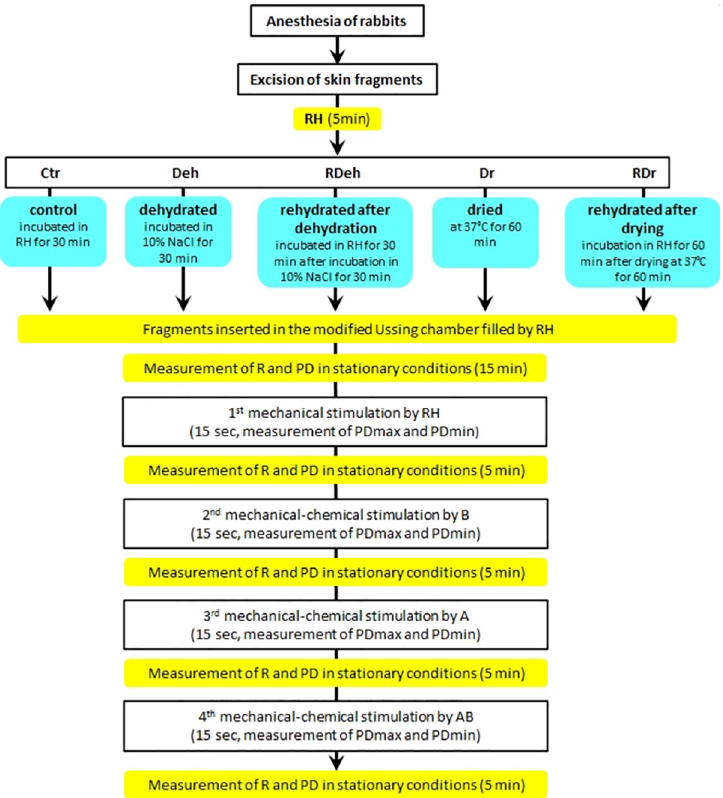
Fig 1. Study design. Abbreviations: RH–Ringer’s solution; NaCl–sodium chloride 10% (1.71 M) in RH; B–bumetanide solution (0.1 mM), used as a blocker of the Na + –K + –Cl – –cotransporter; A–amiloride solution (0.1 mM), used as blocker of ENaC (epithelial sodium channel); AB–solution of amiloride (0.1 mM) and bumetanide (0.1 mM); PD– transepithelial potential difference of the skin specimens measured in stationary conditions (mV); PDmax–maximal transepithelial potential measured during a 15–sec stimulation of the skin specimens (mV); PDmin–minimal transepithelial potential measured during a 15–sec stimulation of the skin specimens (mV); R–resistance ( O /cm 2 ).